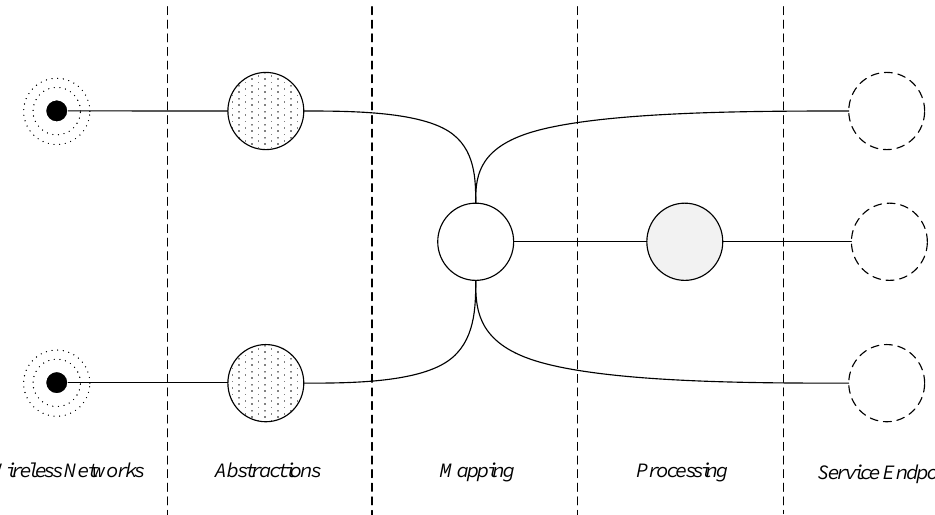
Figure 1. An abstract representation of the system. Wireless sensor networks on the left are integrated using Application Programming Interfaces (APIs). Their data are collected in a central point that provides an abstraction for devices with multiple network interfaces. From this central point, data are distributed to processing nodes and other